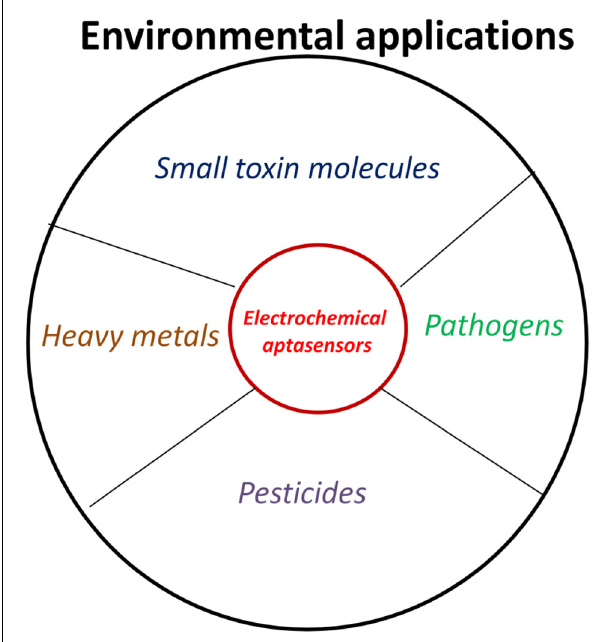
FIGURE 4 | Environmental applications of electrochemical